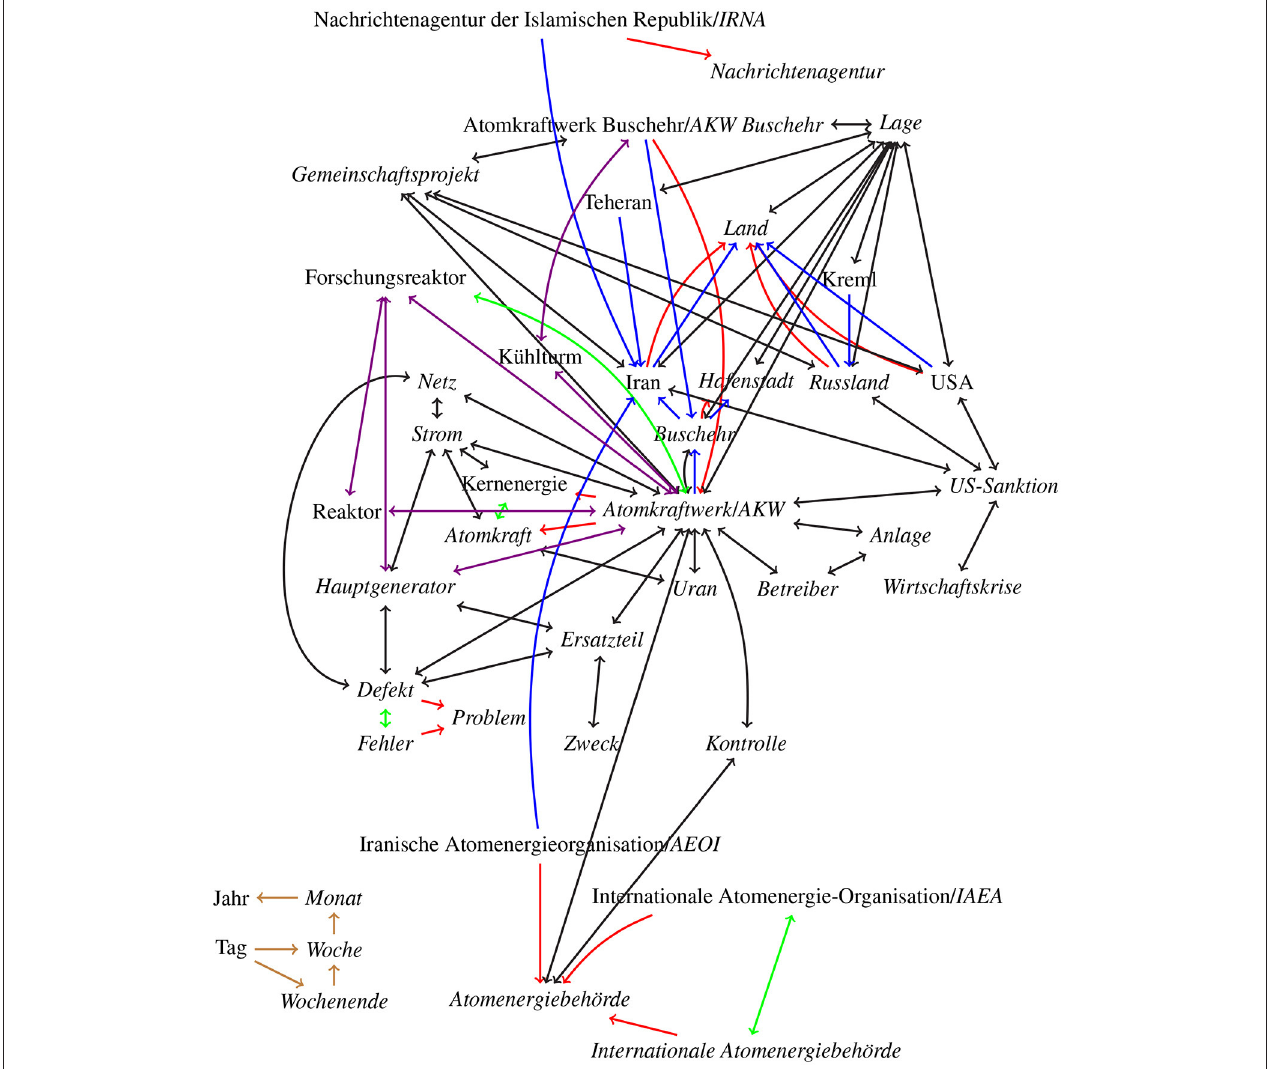
FIGURE 3 | Approximated word graph for our second example text from Heise. All italic words occur in the text. Green arrows represent synonym-relations, red arrows hypernym relations, blue arrows location-based-relation, violet arrows meronym/holonym relations, brown arrows time based-relations, and black arrows co-occurrences relations. Translations are listed in Table 2